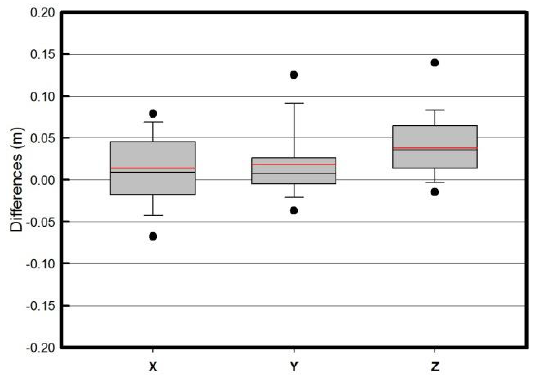
Figure 3. Differences between CMP-GPSNet™ and RTX